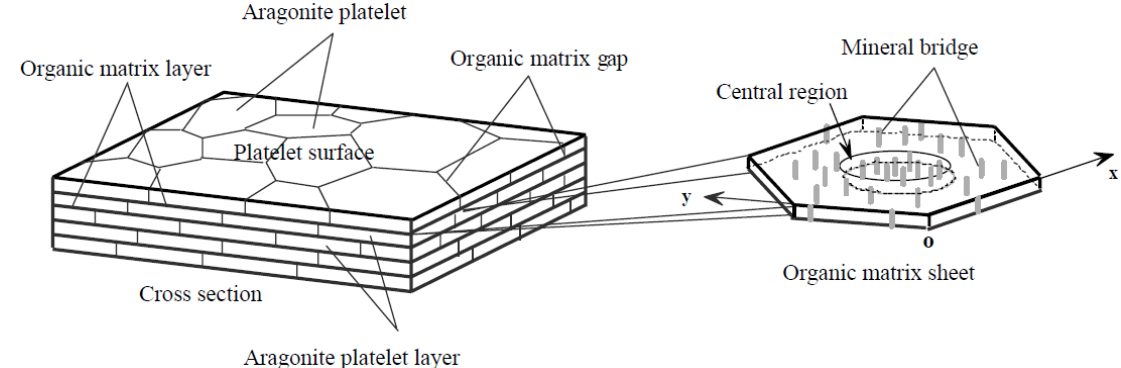
Figure 4. Schematic illustration showing the “brick and mortar” microarchitecture of nacre; the mineral bridges in an organic matrix sheet. While we are considering the mineral bridges to in fact be nanoasperities, the image shows the pores in the organic layer and therefore the arrangement of these nanoasperities. Reproduced from [16] with permission from